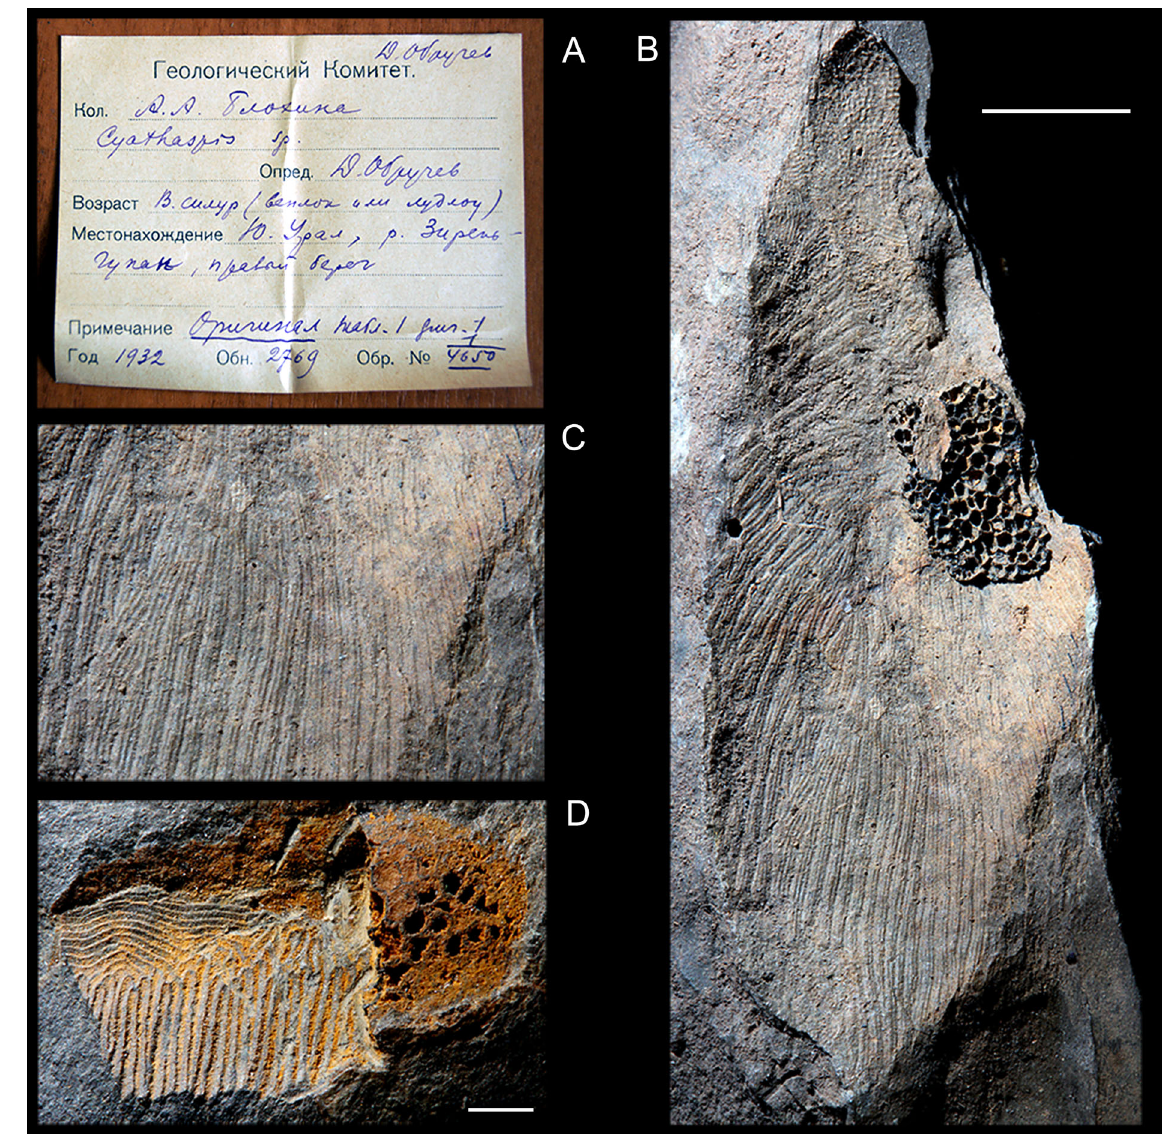
Fig. 7. Archegonaspis bashkirica sp. nov. A , original label of the holotype, the Central Scientific Research Geological Museum, St Petersburg; B , holotype No. 4650-1 (Obruchev 1938, pl. 1, fig. 1), the mould of the external surface of the undivided dorsal and ventral shields in the Central Scientific Research Geological Museum, St Petersburg; locality 2769, near the village of Irgizla, 15 km upstream of the mouth of the Siren-gupan River, right bank of this river, Belaya River basin, the Southern Urals, Bashkiria, Russia; age determined as Ludlow (Obruchev 1938, pp. 37–38); C , the close-up of the holotype in Fig. 7B; D , scale 4650-2 (Obruchev 1938, p. 38, pl. 1, fig. 2), locality 1944 of the same area as for holotype. Scale bars = 5 mm (B); 1 mm